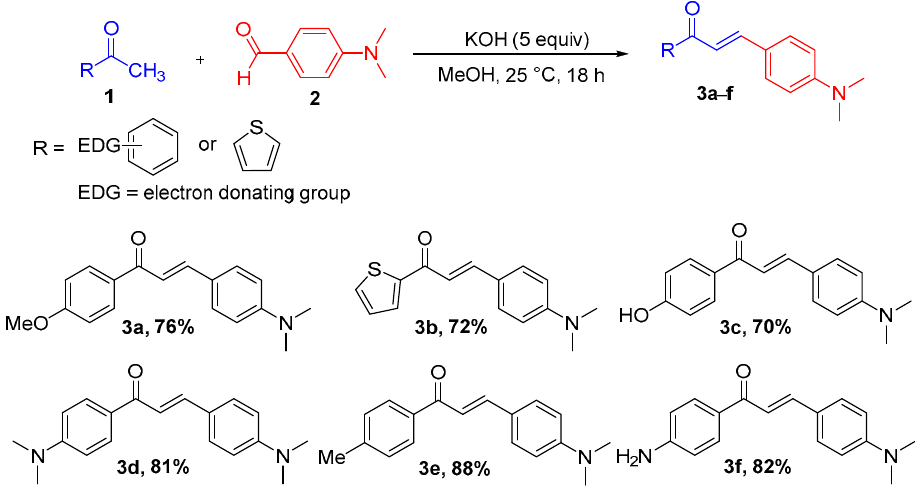
Scheme 1. Synthesis of chalcones 3a – f via the Claisen–Schmidt reaction.